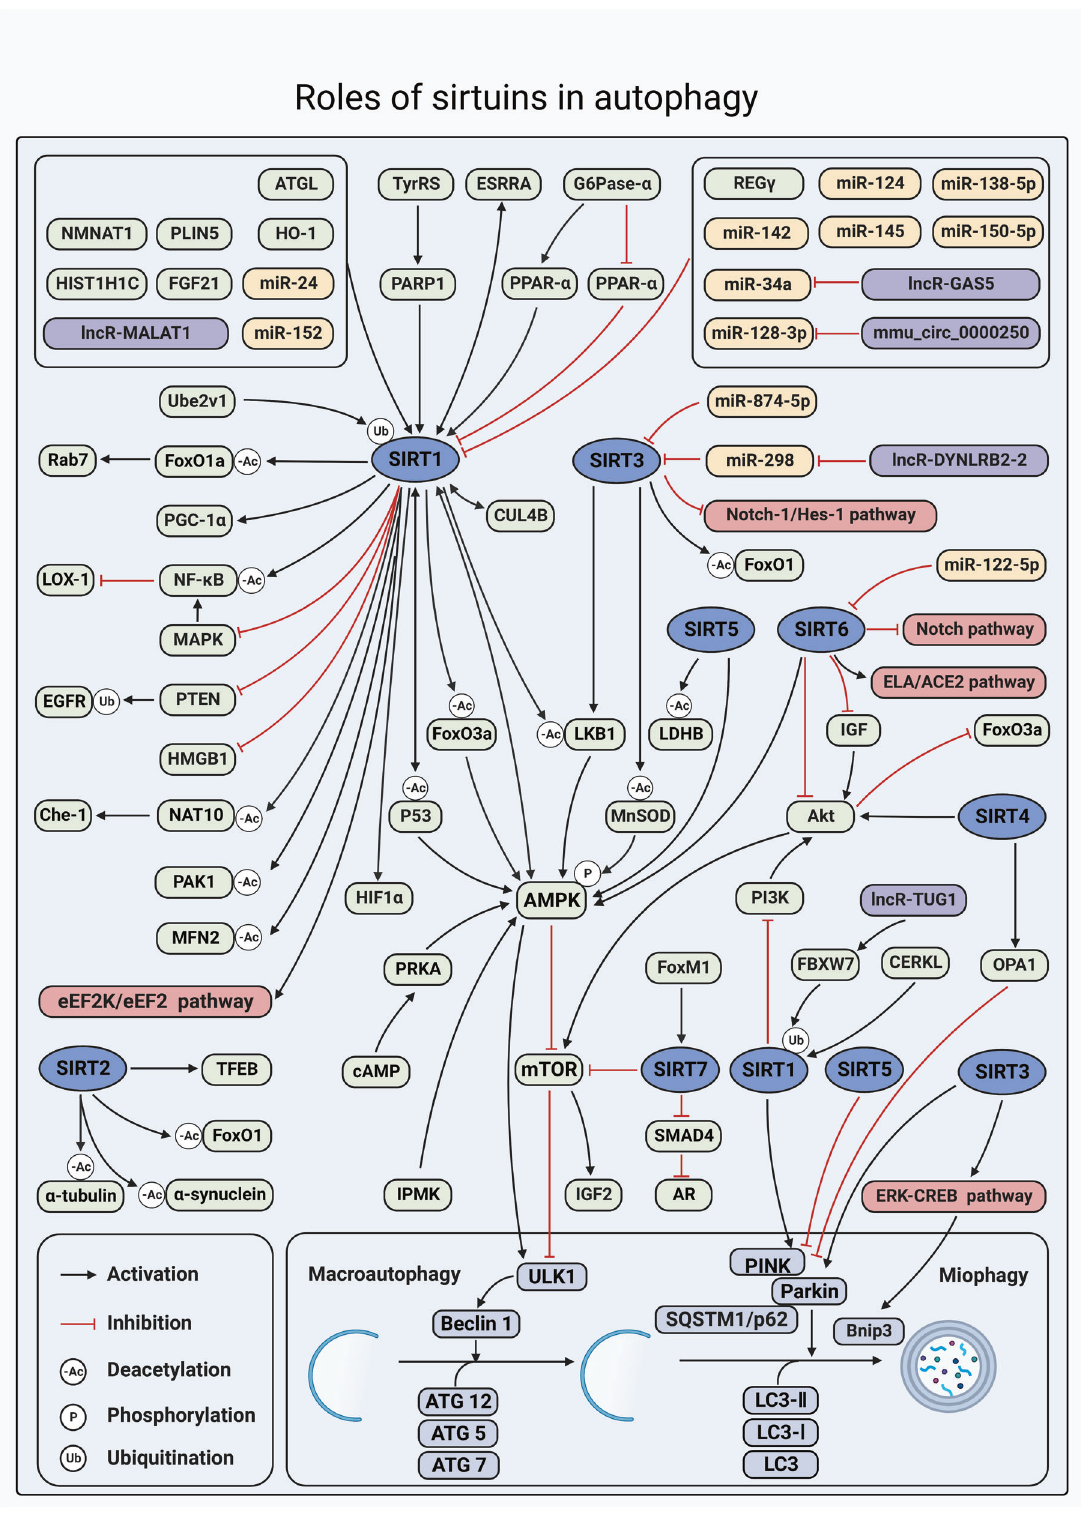
Besides, resveratrol pretreatment reduces tumor